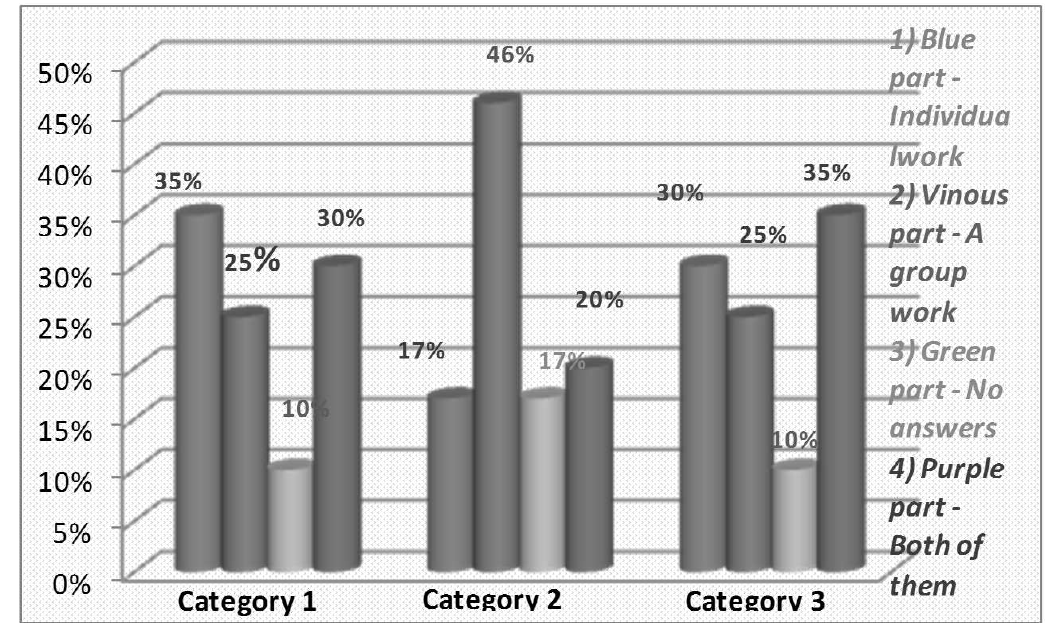
Fig.2. The cylinder diagram is to identify the percentages of each categories’